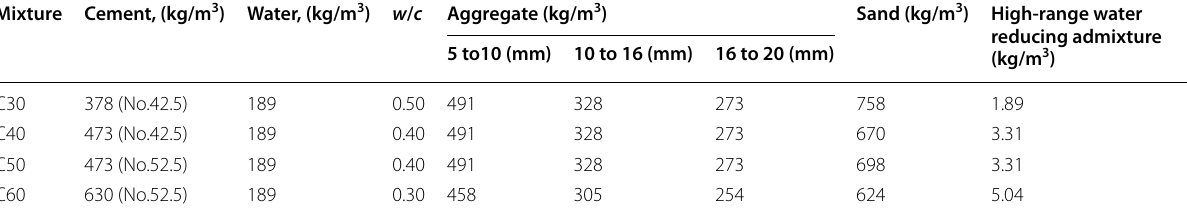
Table 2 Concrete mixture proportion.